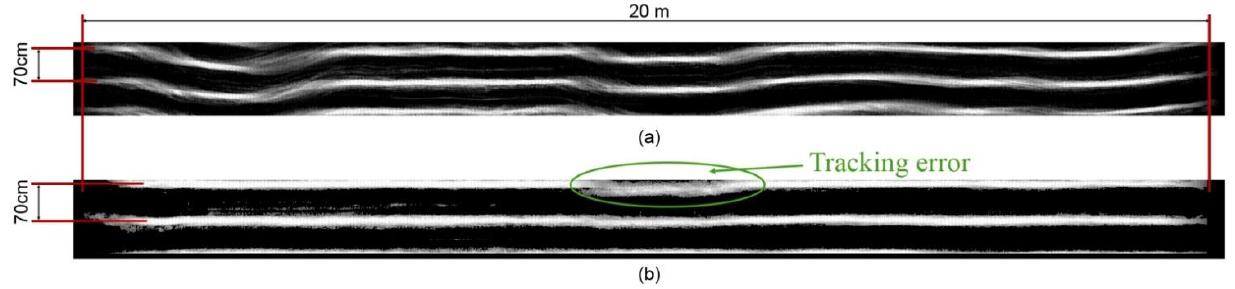
Figure 6. (a) Grayscale image of the generated field map for a video sequence without stabilization. The crop rows meander along the moving direction; (b) After the stabilization process, the crop rows remain straight despite the camera sway. The area where the left row twists is due to a tracking error.